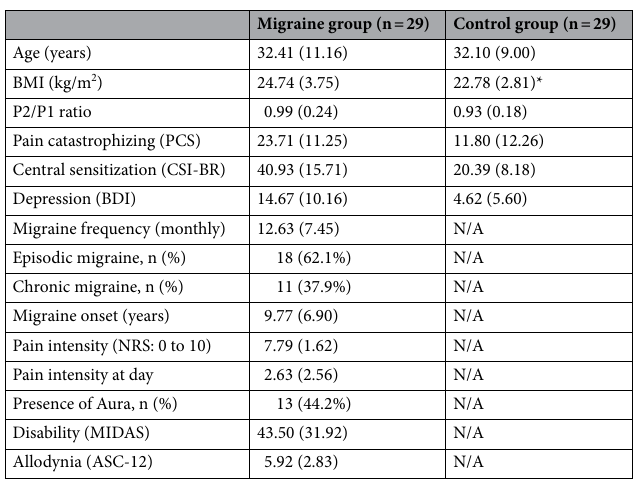
Table 1. Descriptive data which values are presented as mean (SD) and frequency (percentage). BMI, body mass index; NRS, numeric rating scale; MIDAS, Migraine Disability Assessment, ASC-12, 12-item allodynia symptom checklist; BDI, Beck Depression Inventory. * p < 0.05 for independent samples